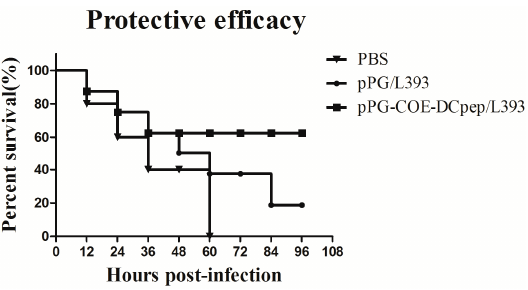
Figure 3. Protection after Porcine epidemic diarrhea virus (PEDV) infection. The pPG-COE-DCpep/L393 , pPG/L393 , and PBS groups were orally infected with PEDV (1 × 10 6 PFU/mL) on the fifth day post-vaccination. All piglets of the pPG-COE-DCpep/L393 , pPG/L393 , and PBS groups were euthanized, and dissection at four days post-infection (DPI). Table 2. Weight change of piglets.